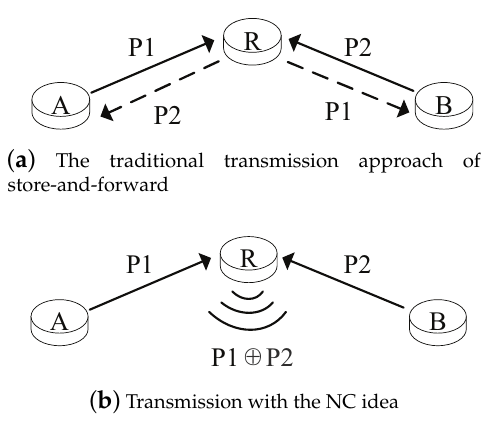
Figure 1. A simple example of the network coding (NC)